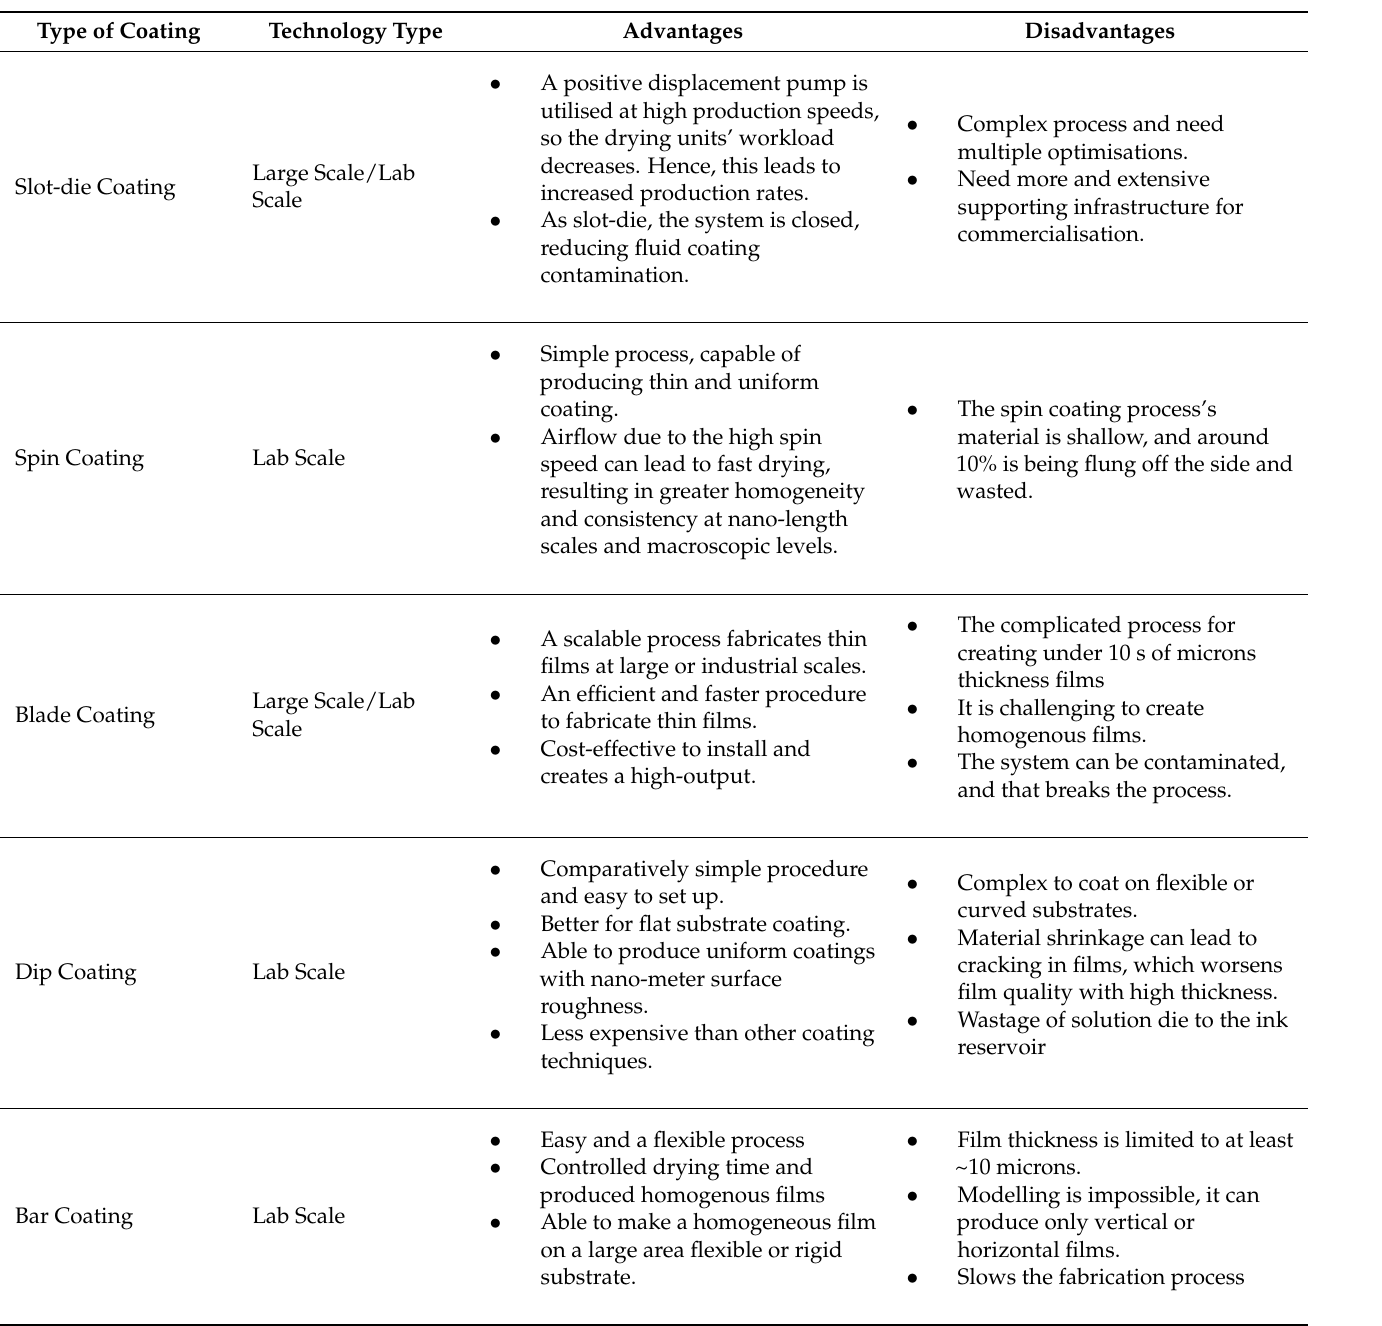
Table 2. Characteristics of Different Coating